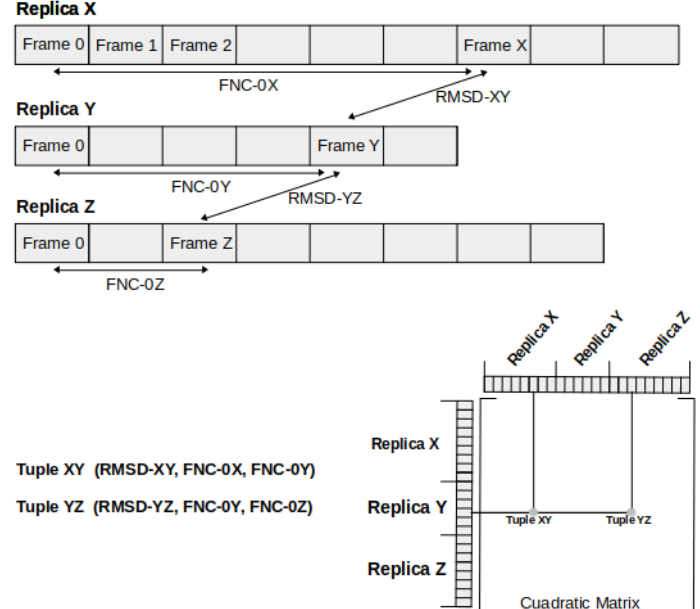
Figure 9. Schematic diagram exhibiting how the RMSD matrix and the set of tuples with FNC were constructed. RMSD-XY were obtained between Frame-X and Frame-Y, FNC-0X is the FNC between Frame-X and the initial Frame of the replica X, and FNC-0Y is the FNC between Frame-Y and the initial Frame of the replica Y. Thus, Tuple XY will be (RMSD-XY,FNC-0X,FNC-0Y). In the same manner, Tuple YZ was constructed. Obtaining a quadratic matrix with a total of Tuples = ( Total frames ) 2